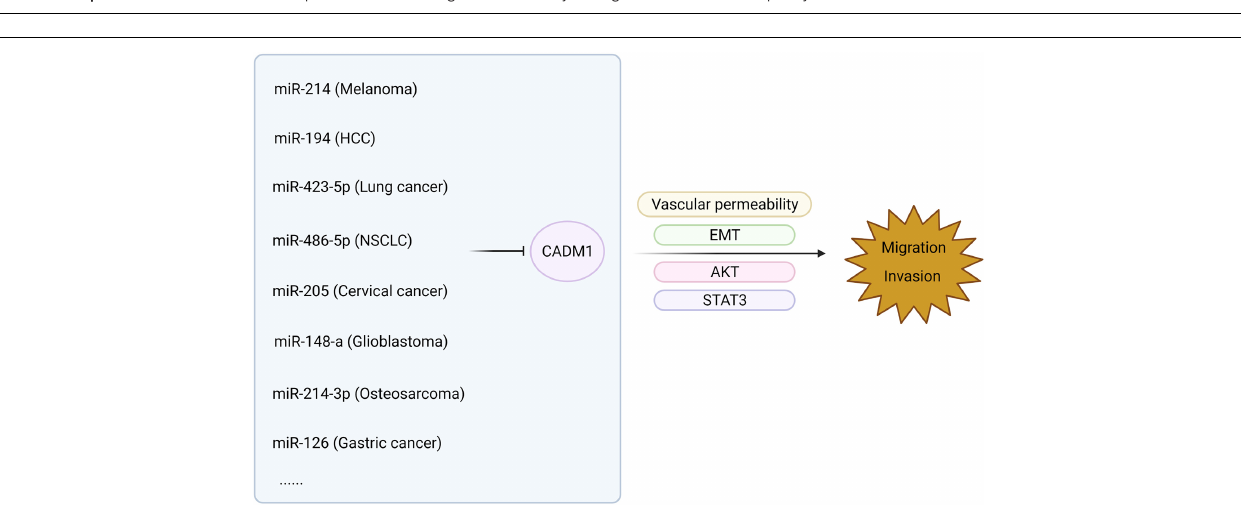
Frontiers in Cell and Developmental Biology |